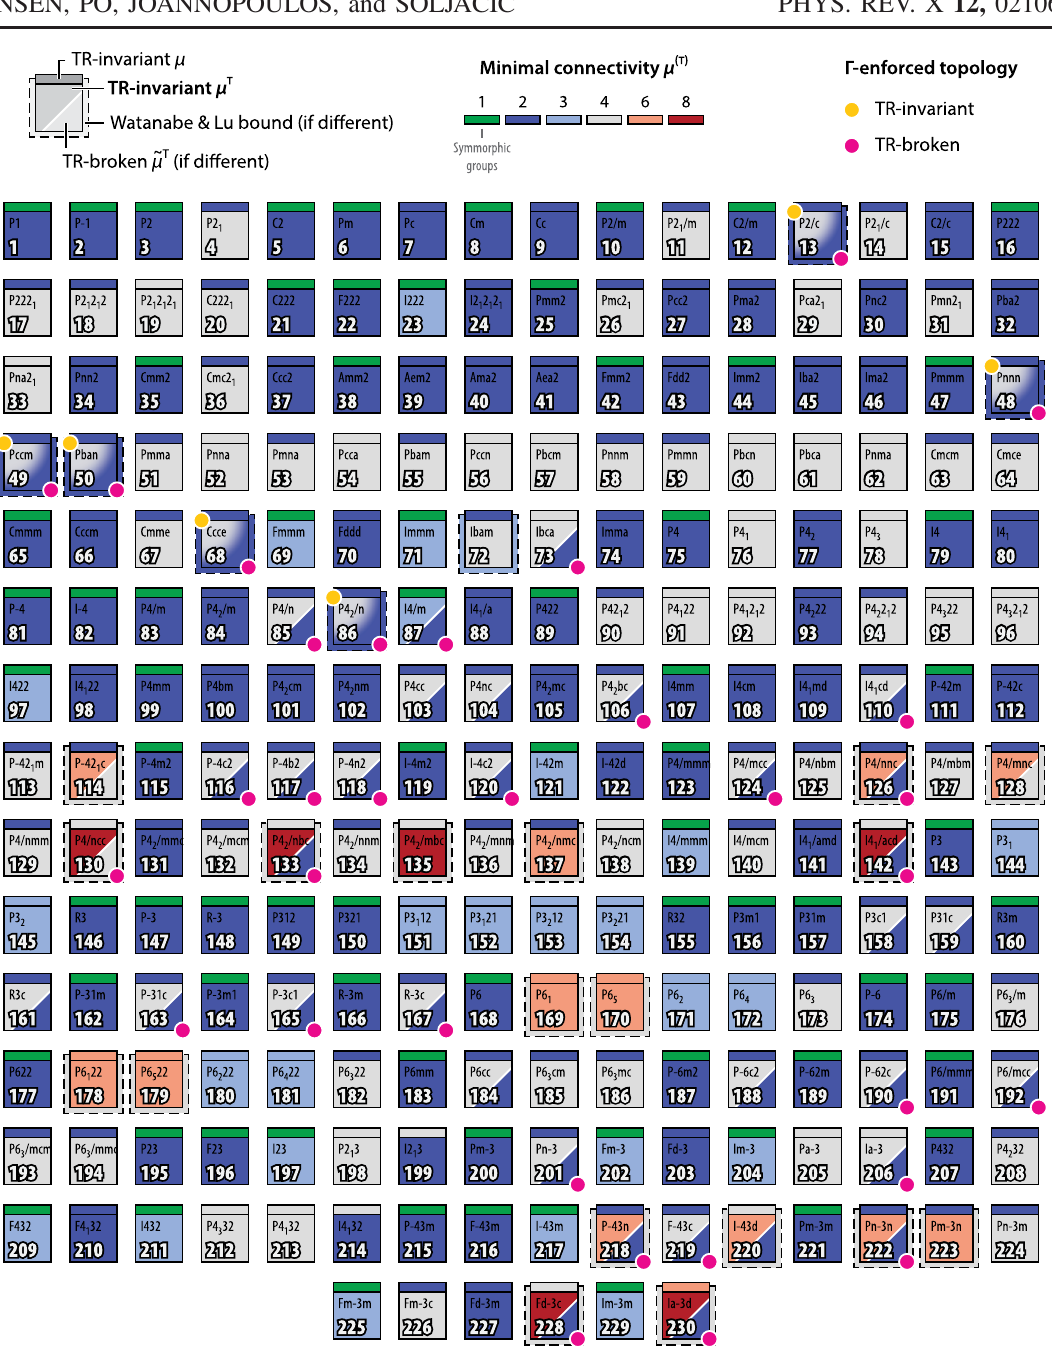
FIG. 2. Minimum photonic band connectivity and Γ -enforced topology. The TR-invariant minimum transverse band connectivity below the first gap, μ T , is given for each space group (labeled squares). Watanabe and Lu ’ s [16] lower bounds are shown (dashed boxes) when our explicit solutions exceed them. The corresponding TR-broken connectivities ˜ μ T are shown (lower triangular cutouts) when they differ from their TR-invariant counterparts. Minimum-connectivity solutions with Γ -enforced topology are highlighted by circular markers (in yellow, with TR; in pink, without TR). TR-invariant minimum regular connectivities μ are shown as context (narrow rectangles). Compatibility relations allow μ T ¼ 2 solutions in space groups 13, 48 – 50, 68, and 86 (lower-diagonal box shading); however, they are topologically obstructed (i.e., incompatible with a gap) because of Γ -enforced nongaps, which increases μ T to 4 (upper-diagonal box omit trivial factor groups, i.e., write Z λ × Z 1 as Z λ and (equivalently, ν ¼ 0 denotes a trivial index): With TR i i i Z … × Z Z symmetry, there are 53 such space groups, all correspond- 1 × 1 as 1 . Space groups with symmetry- ≠ Z ing to topological nodal features [52]. Denoting by B the identifiable topology have indicator groups X 1 BS